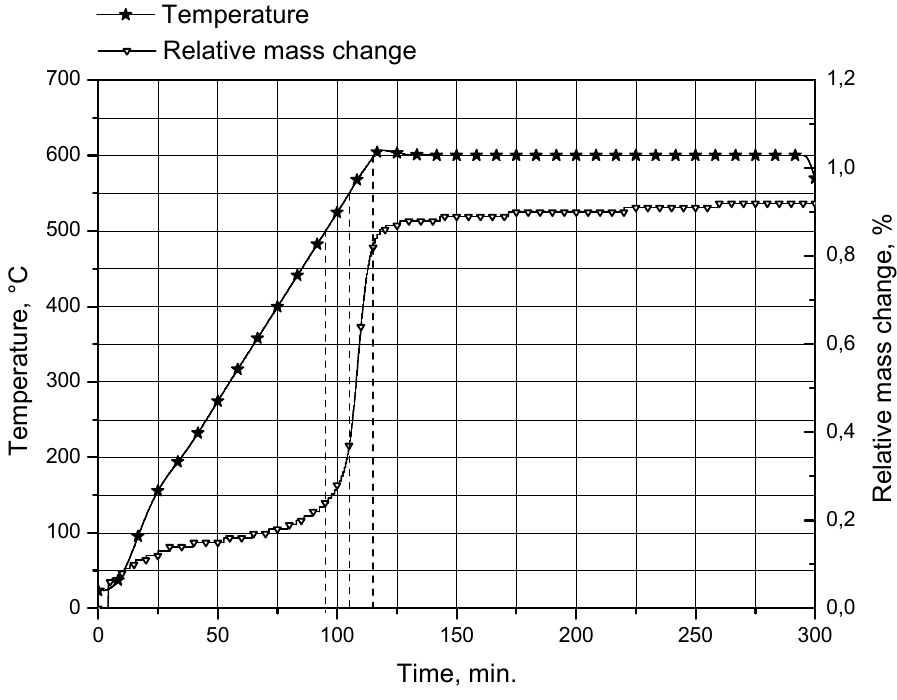
Figure 8. TG curve for original aluminum powder. The TG curve is steepest between approximately 500 and 600 °C (levels of 500, 550 and 600 °C are marked with dashed lines). Within this range, the relative mass change (attributed to the formation of a passive aluminum oxide layer on the powder particle surfaces) rose from 0.24 to 0.83%. This result is consistent with the formation of a considerably thicker passive oxide layer at temperatures over 500 °C.